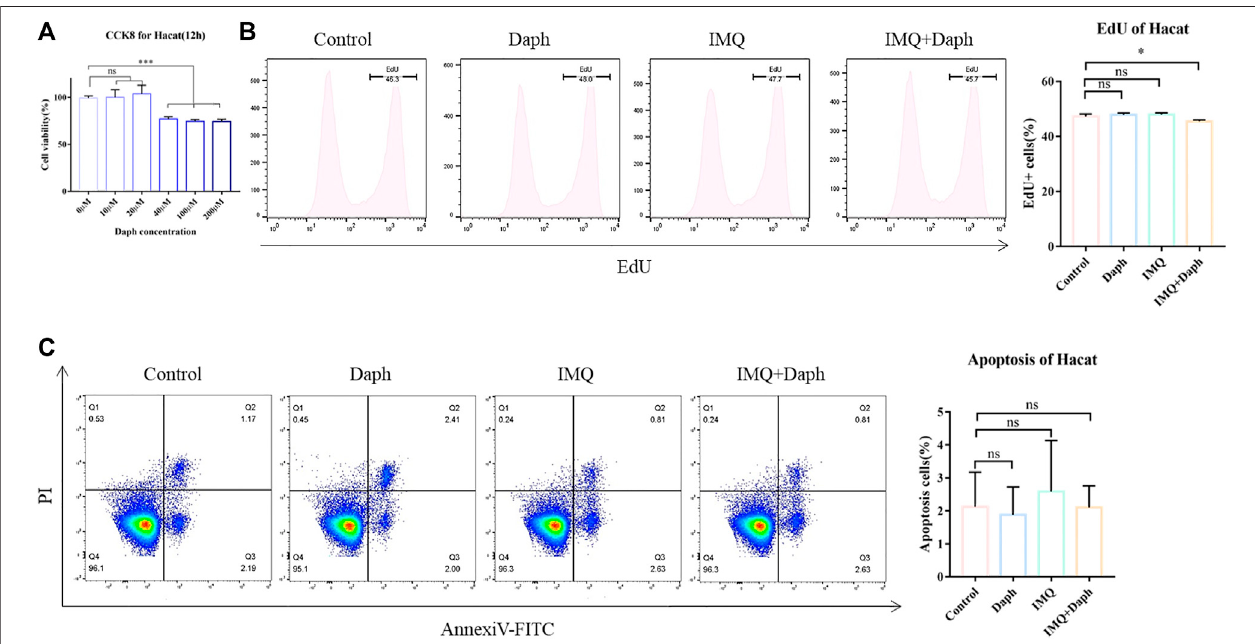
FIGURE7| HaCaTcellin fl ammationmodelwasinduced invitro andtheeffectofDaphonitscharacteristicswasdetected. (A) CCK-8wasusedtodetecttheeffect of different concentrations of Daph on the activity of HaCaT cells. (B) In fl ammatory state of HaCaT cells was induced by IMQ, and the effect of Daph on its proliferation was detected by an Edu test. (C) Effect of Daph on HaCaT cell apoptosis was detected. Data are shown as mean ± SE (* p < 0.05; ** p < 0.01).